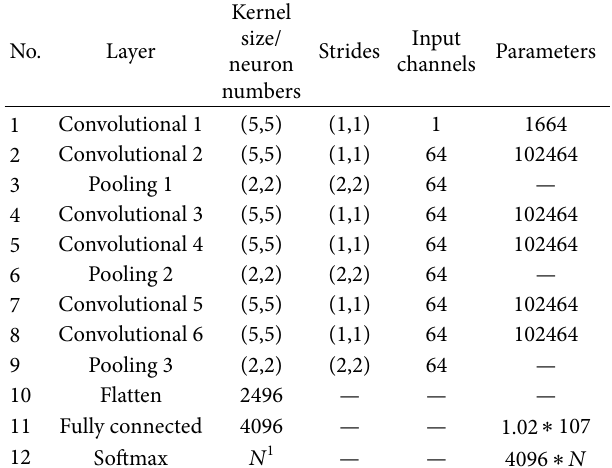
Table 1: Architecture and parameters of the proposed network.